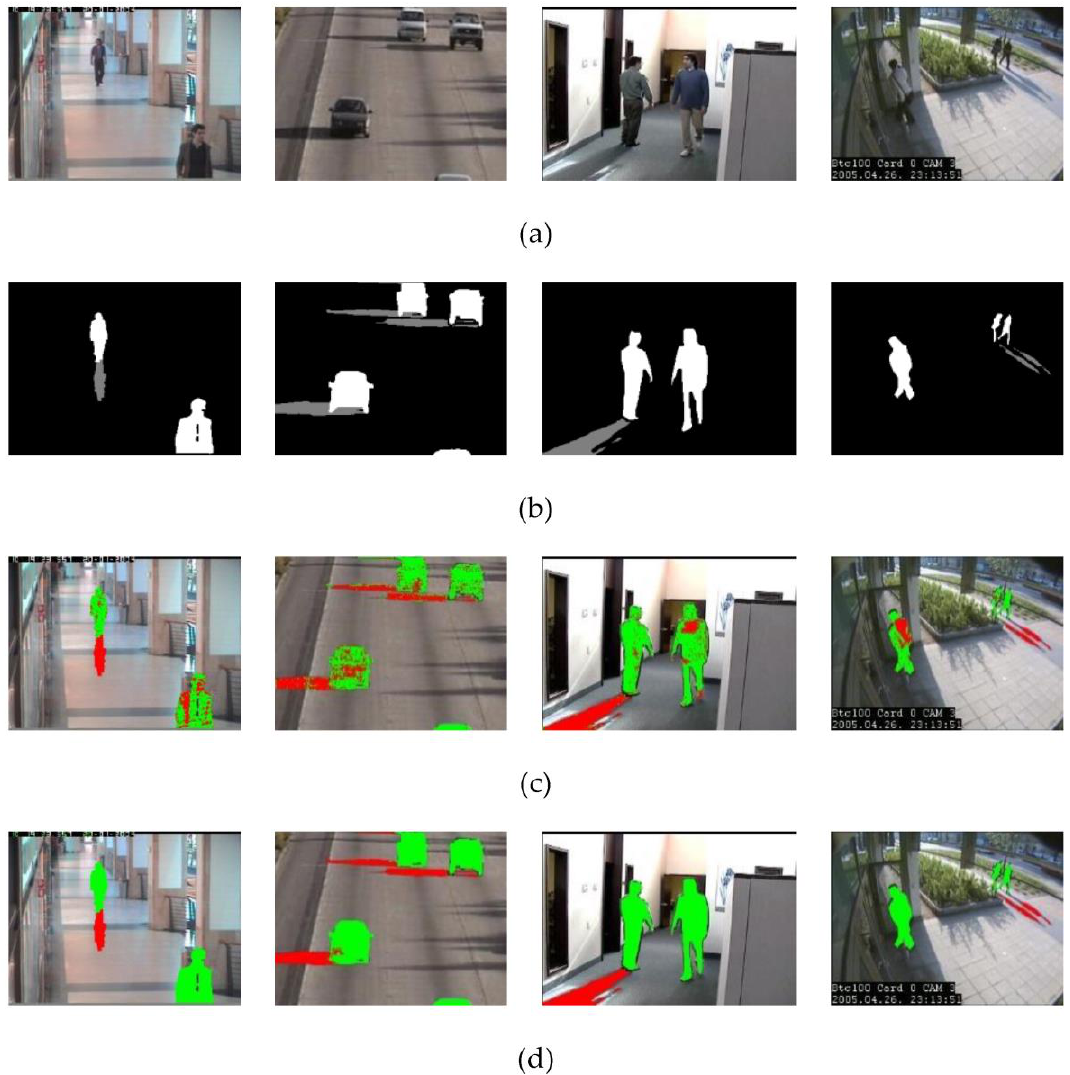
Figure 2. Shadow detection results of some frames in different scenes. ( a ) original frames; ( b ) groundtruths; ( c ) classification results. The shadows are marked with red and objects are marked with green; ( d ) final results after post-processing.